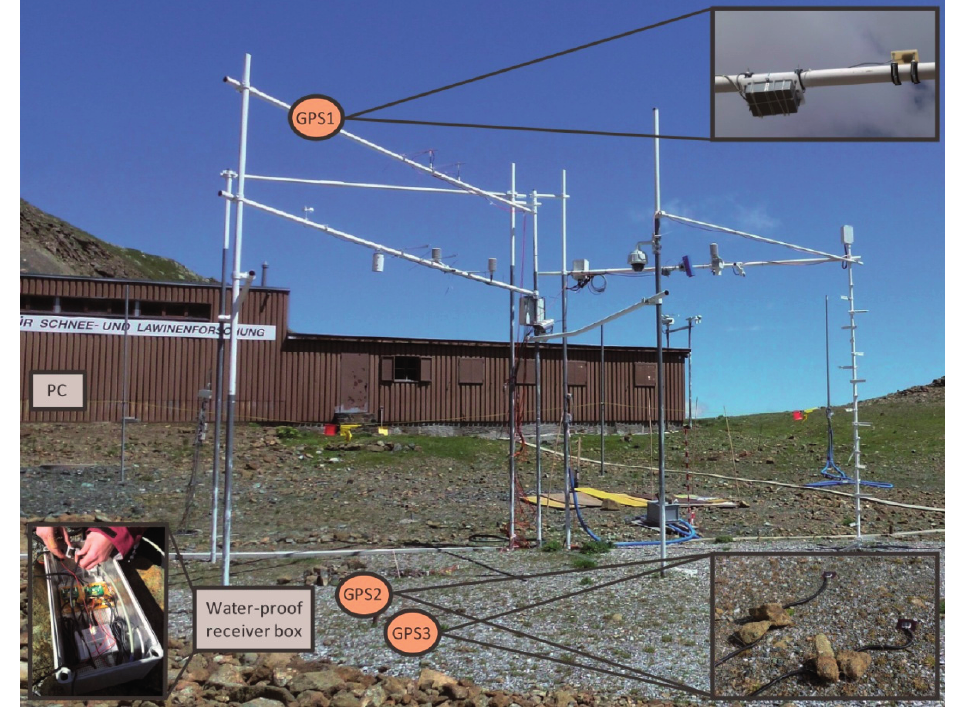
Figure 1. Overview of the location of the water-proof box with the Fastrax IT430 receivers, the hut where the PC was located and the Hirschmann GPS7M antennas of GPS1, GPS2